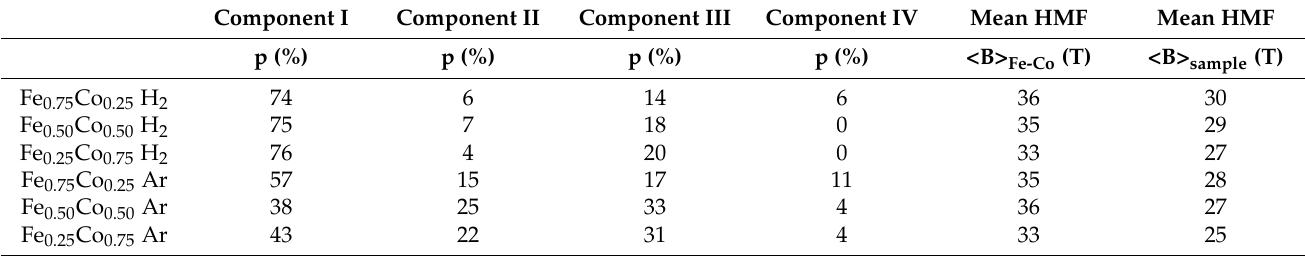
Figure 5. Room temperature Mössbauer spectra collected for the Fe-Co nanochains annealed in ( a ) hydrogen-containing atmosphere, and ( b ) argon atmosphere; component I—blue lines, component II—red line, component III—orange line, and component IV—olive and grey lines. Table 3. Parameters of components of Mössbauer spectra collected for Fe-Co nanochains annealed in hydrogen-containing atmosphere and in argon: p—relative intensity, <B>—mean HMF. Components: component I—iron-cobalt alloy, component II—iron and/or iron-cobalt oxides, component III—paramagnetic and/or superparamagnetic component, and component IV—other magnetic phases mentioned in text.